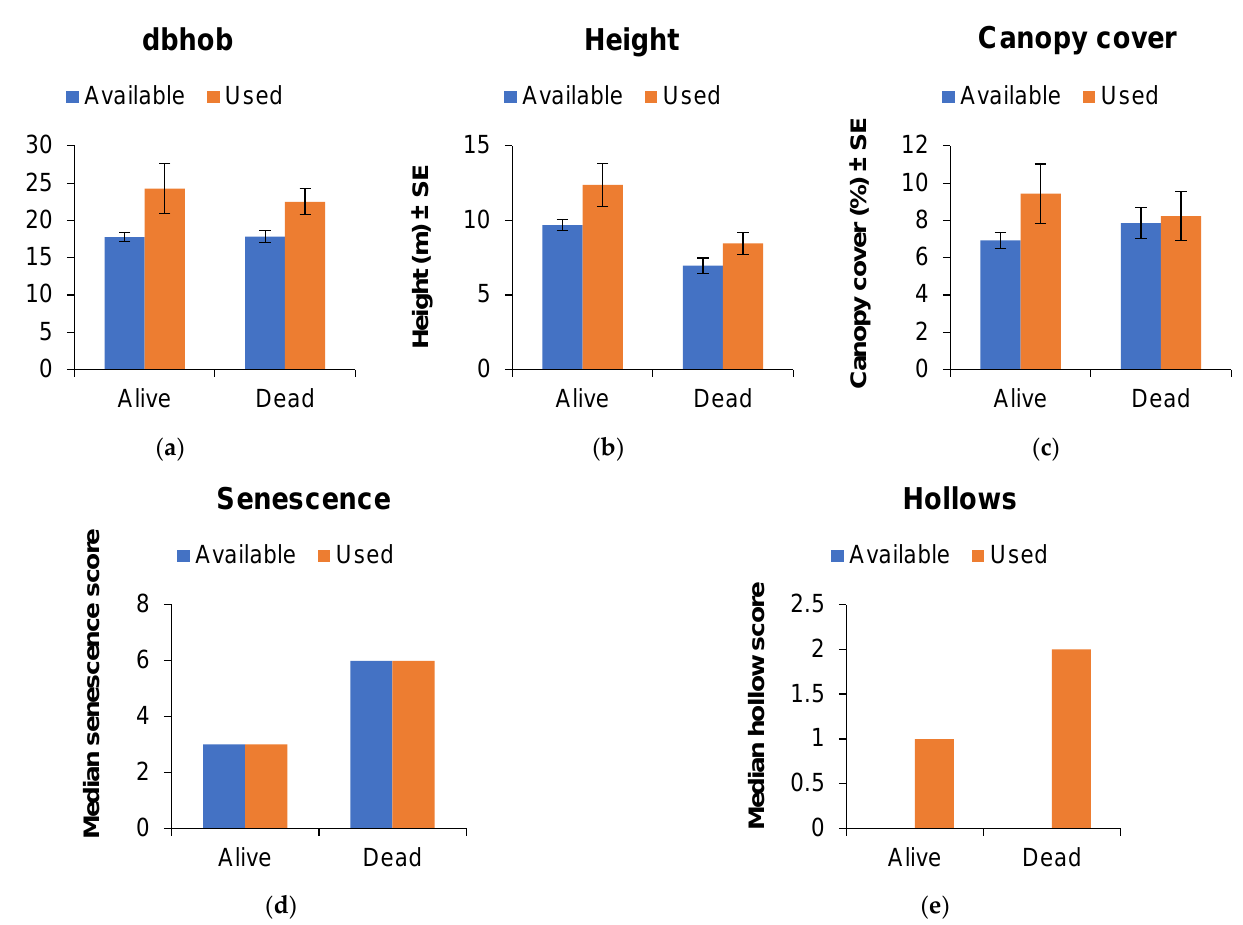
Figure 4. Column graphs illustrating the characteristics of roost (used) and locally available trees (>10 cm dbhob) represented by living and dead trees in the AWC site, Central Pilliga: ( a ) diameter at breast height over bark, ( b ) height, ( c ) canopy cover, ( d ) senescence and ( e ) hollow index. A canonical analysis of principal coordinates revealed that trees used for roosting by N . corbeni were positively associated with hollow abundance and this was particularly the case for dead trees with hollows (Figure 5). Living and dead trees not used for roosting tended to not have hollows and were smaller than trees used for roosting (though these were still relatively small; ~23 cm on average).